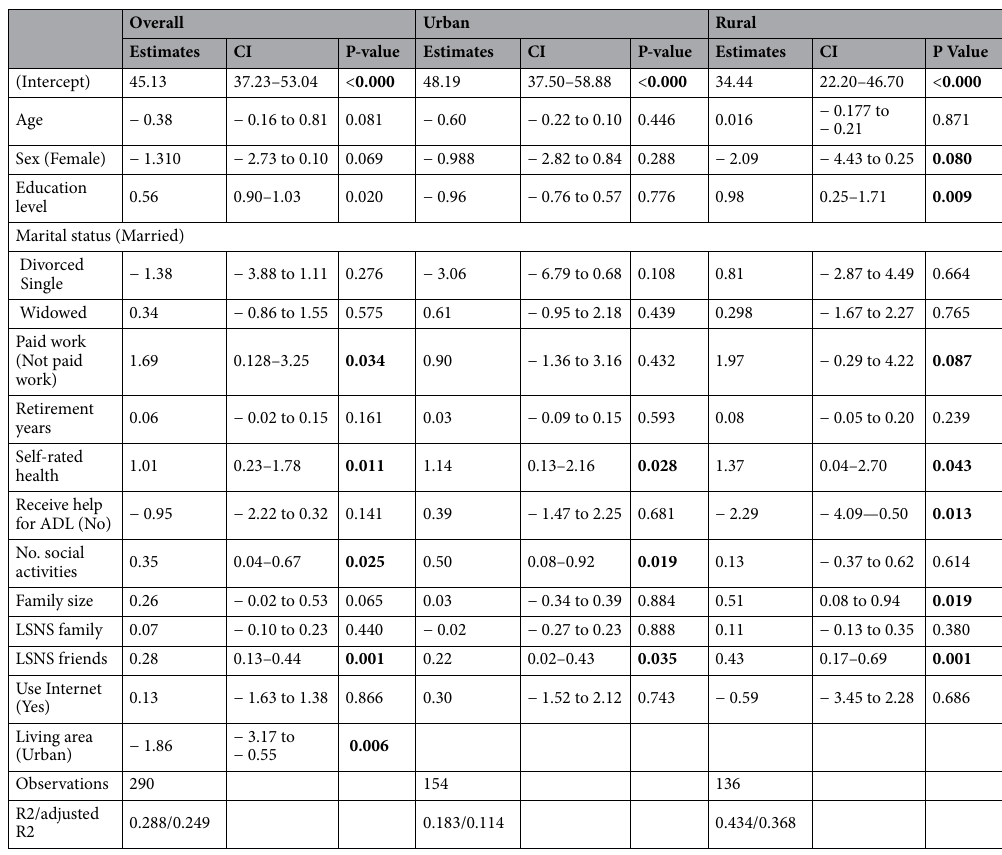
Table 3. Socio-demographic determinants of flourishing among Mongolian older adults by area of residence. *Bold text indicates statistically significant